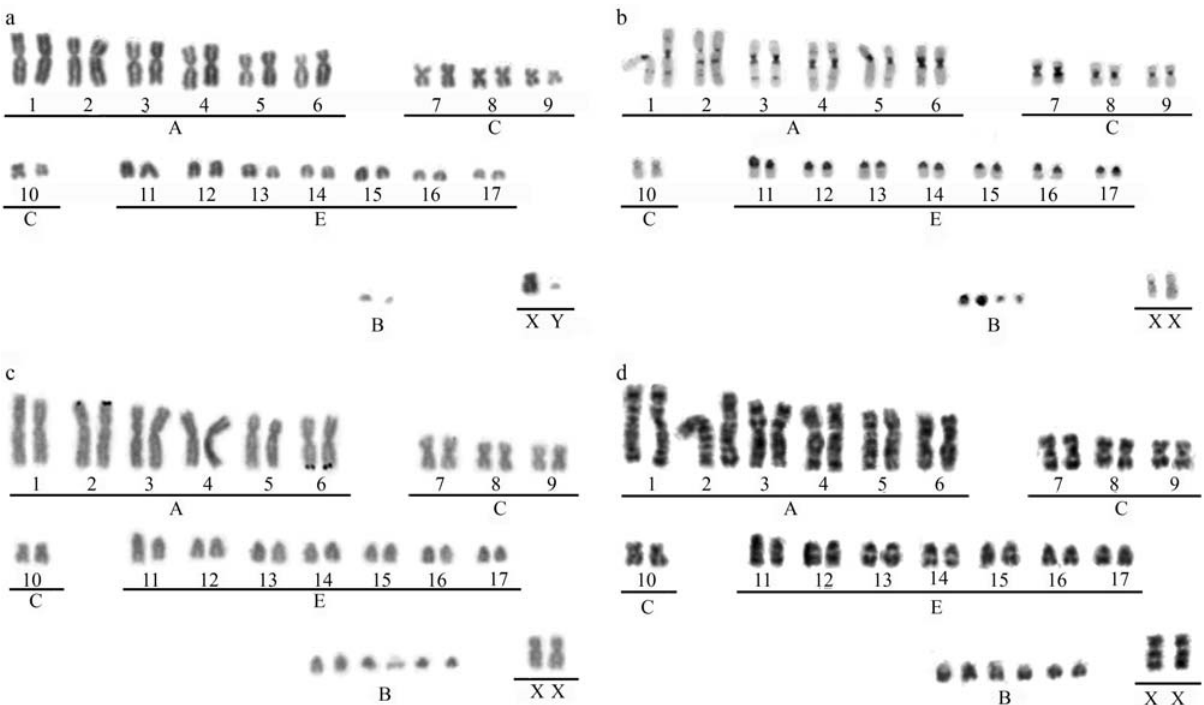
Figure 1 - Karyotype V01 of Mazama nana (2n = 36; FN = 58) after (a) conventional Giemsa staining, (b) C-banding, (c) Ag-NOR staining and (d)